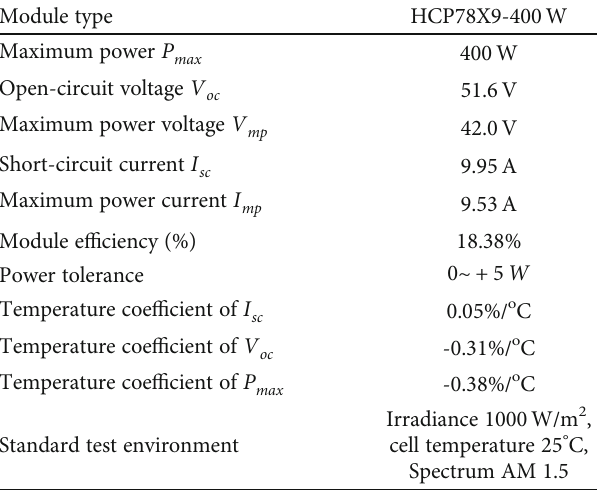
Table 7: Solar photovoltaic speci fi cation [41, 42].